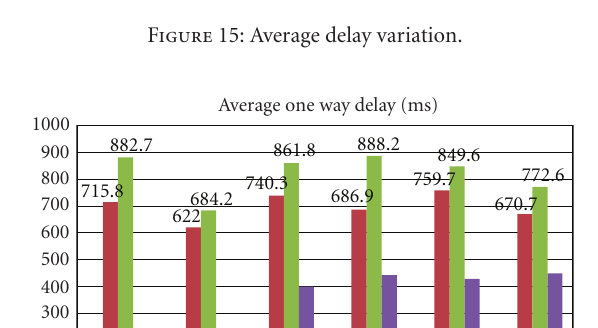
Figure 17: Average packet loss ratio.